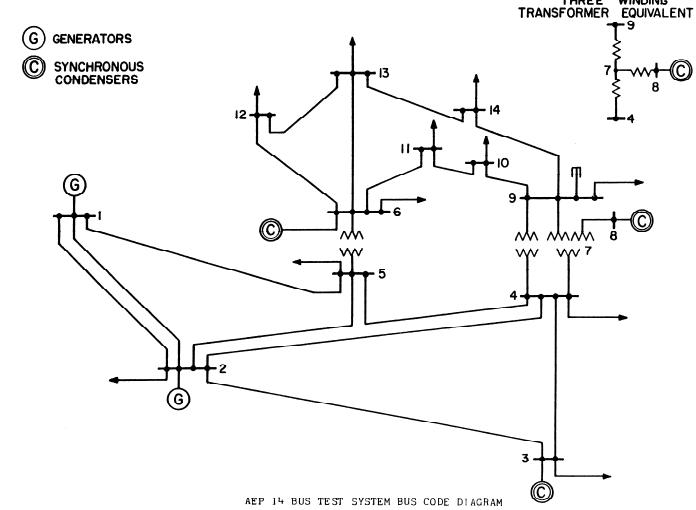
Figure 9. IEEE 14-bus system [43,44].